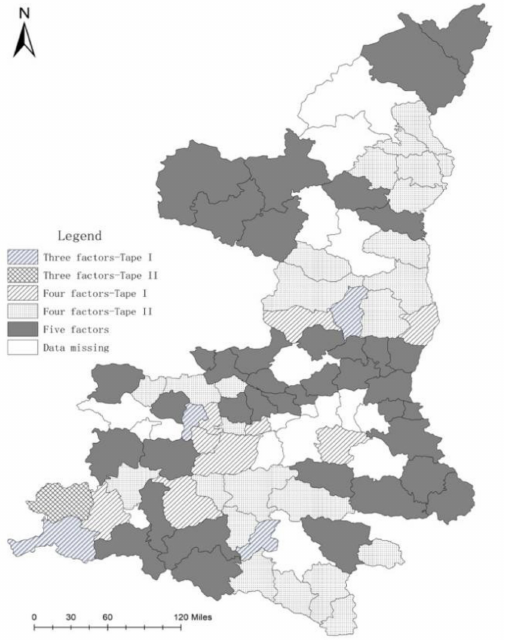
Figure 3. Spatial distribution of green development driving types in rural